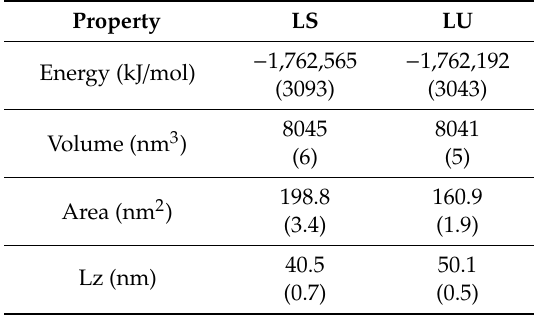
Figure 3. Total system area ( A ) and box in z direction (Lz) ( B ) are shown for both lamellar systems. In both figures, LS and LU are in black and red, respectively. Table 2. Summary of calculated properties for both S and U lamellar systems.